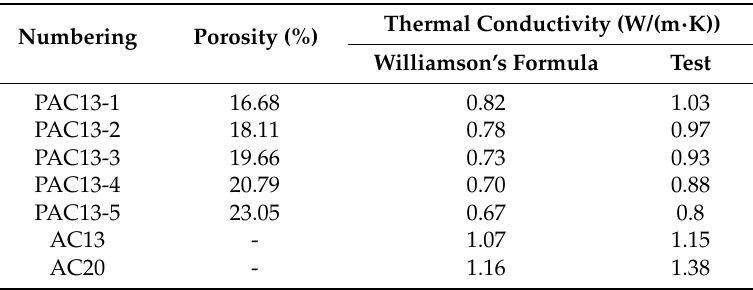
Table 10. Thermal conductivities of 5 cm thick